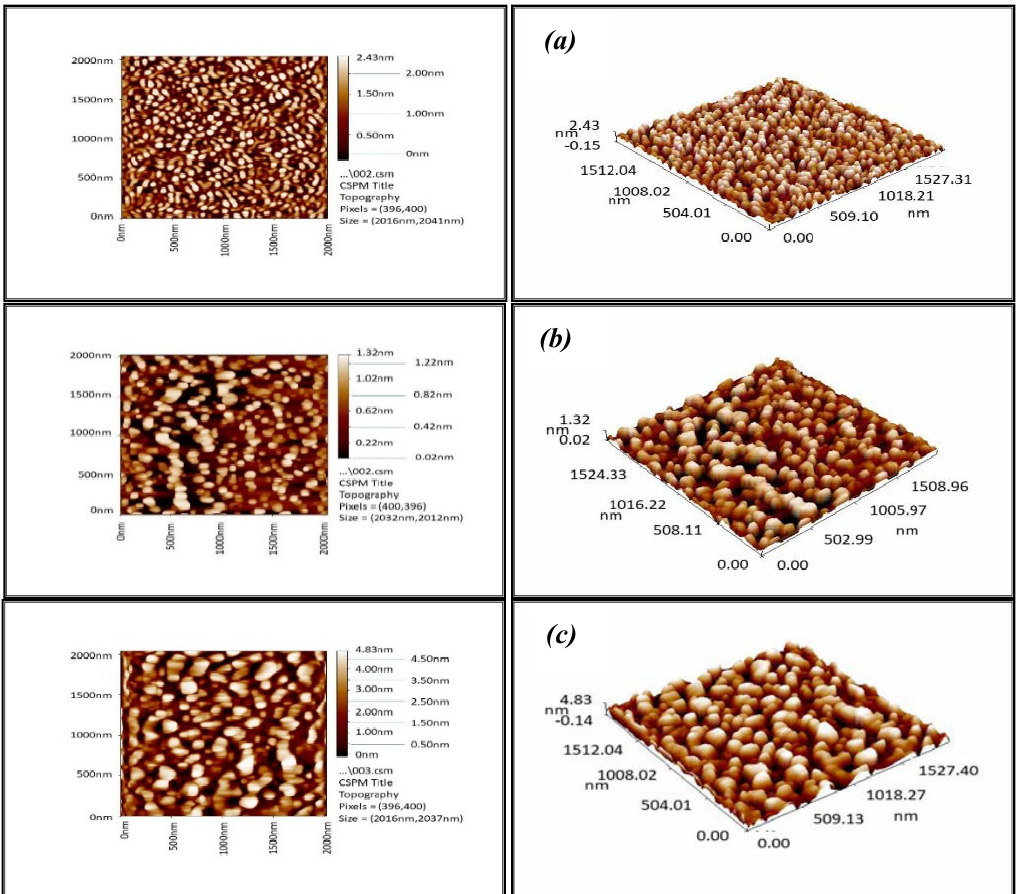
Fig. 3: AFM images of spin coated P3HT thin films at (a) as-deposited thin film (b) Ta=100 ° C (c) Ta=150 °